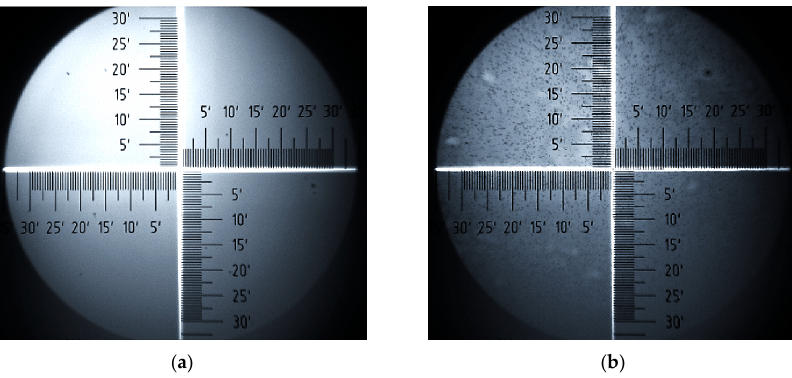
Figure 9. PC60BM before ( a ) and after annealing ( b ). Polymers 2020 , 12 , 1458